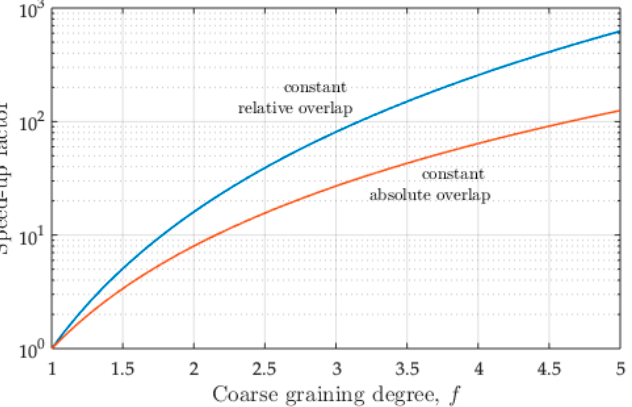
Figure 9. Scaling performance of coarse graining schemes. The speed-up is the computational gain achievable thanks to the coarse graining to simulate a given time, assuming the computational load scales linearly with the number of particles. Table 3. List of selected applications of coarse graining approaches and corresponding perfor- mance improvements.